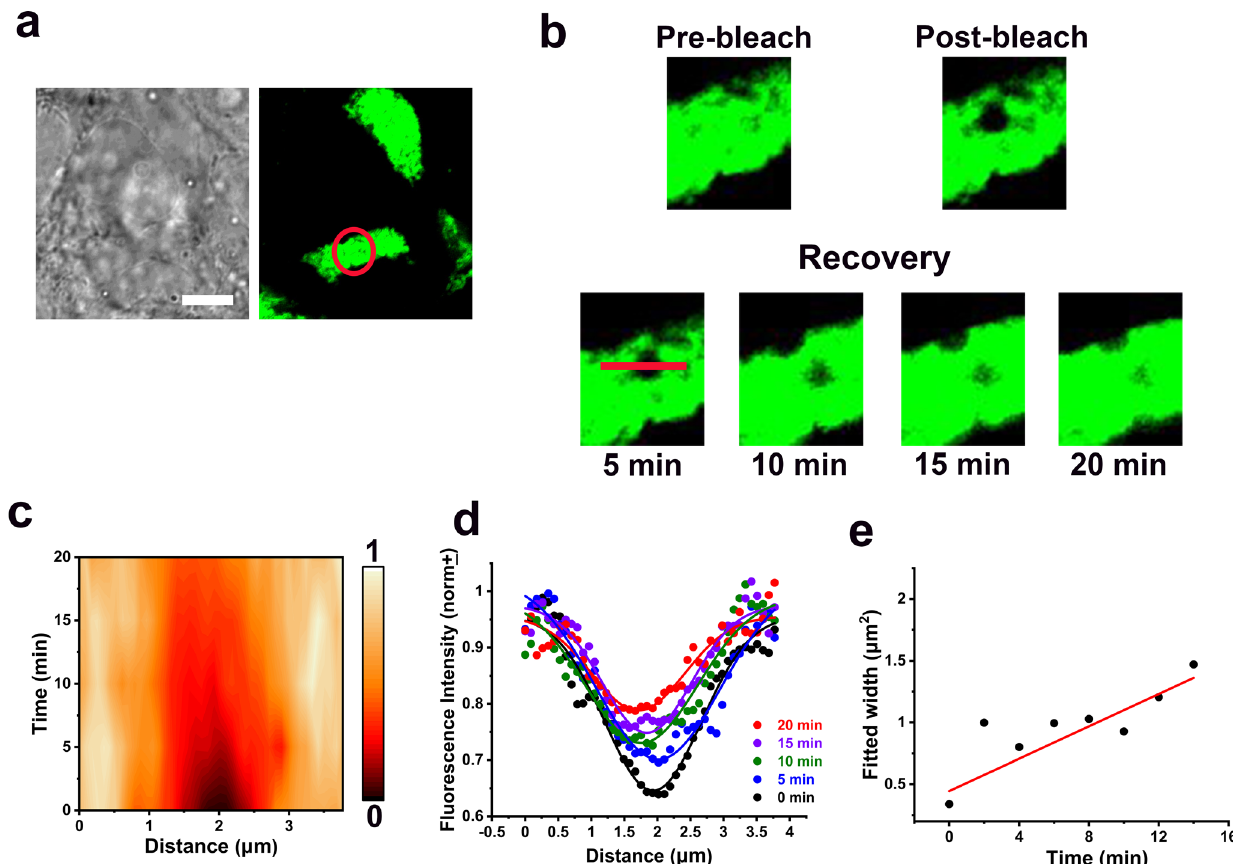
Fig. 5 FRAP to probe the fl uidic cis-clusters of Cdh23 at the cell-cell junctions. a Representative bright- fi eld and fl uorescence images show the localization of Cdh23 at the cell-cell junction of HEK293 cells exogenously expressing Cdh23. Cdh23 is recombinantly tagged with eGFP at C-terminus. The circle (red) indicates the confocal volume for the FRAP experiment. Scale bar: 10 µ m. b The cross-sections of fl uorescence images indicate the regions of the line is 4 µ m. c The contour plot represents the spatiotemporal distribution of Cdh23-eGFP along the red line. d The fl uorescence intensity pro fi le along the red line is plotted with the recovery time points. The solid lines are the Gaussian fi ts. e The widths ( σ 2 ) from the Gaussian fi ts are plotted with recovery time. The solid red line is the linear fi t to the data to estimate the diffusion-coef fi cient. Error bars indicate the standard deviation obtained from the Gaussian fi